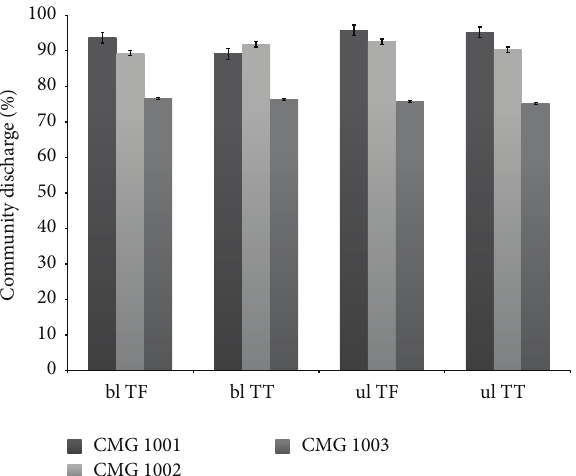
Figure 3: Community discharge by amputation levels for CMG after adjustment of function. ul = unilateral, bl = bilateral, TF = transfemoral, and TT =